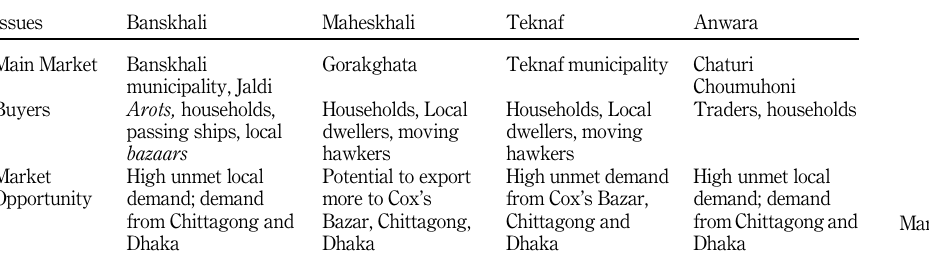
Table 14. Market analysis for fish value